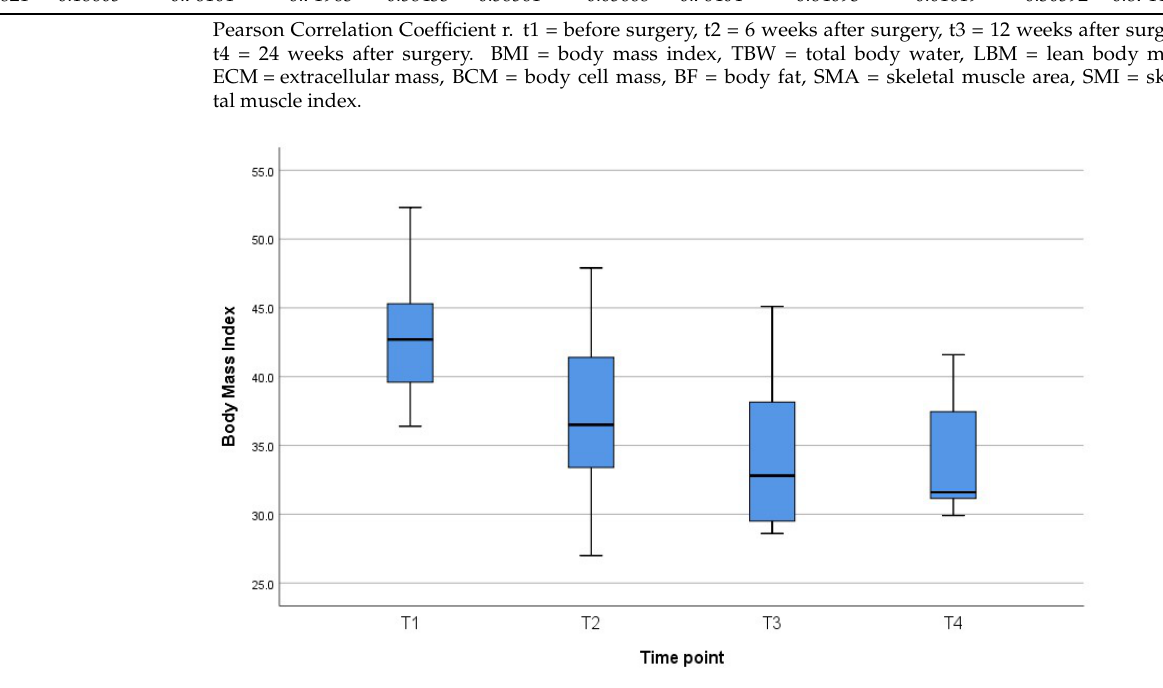
p -values for comparison between the respective time points. t1 = before surgery, t2 = 6 weeks after surgery, t3 = 12 weeks after surgery, t4 = 24 weeks after surgery. BMI = body mass index, TBW = total body water, LBM = lean body mass, ECM = extracellular mass, BCM = body cell mass, BF = body fat, SMA = skeletal muscle area, SMI = skeletal muscle index.